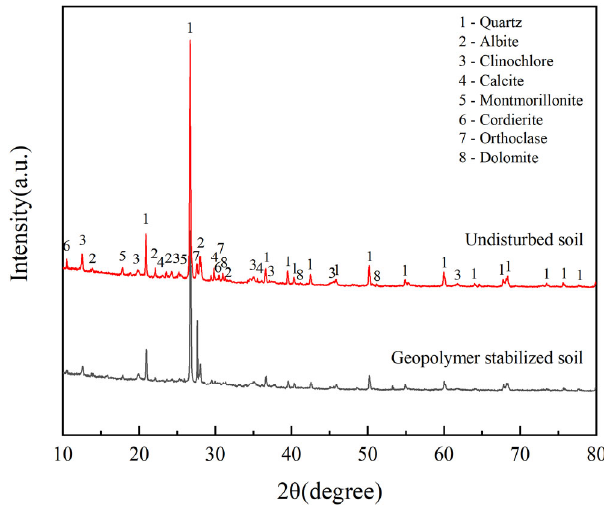
Figure 10. XRD patterns of undisturbed soil and geopolymer ‐ stabilized soil.